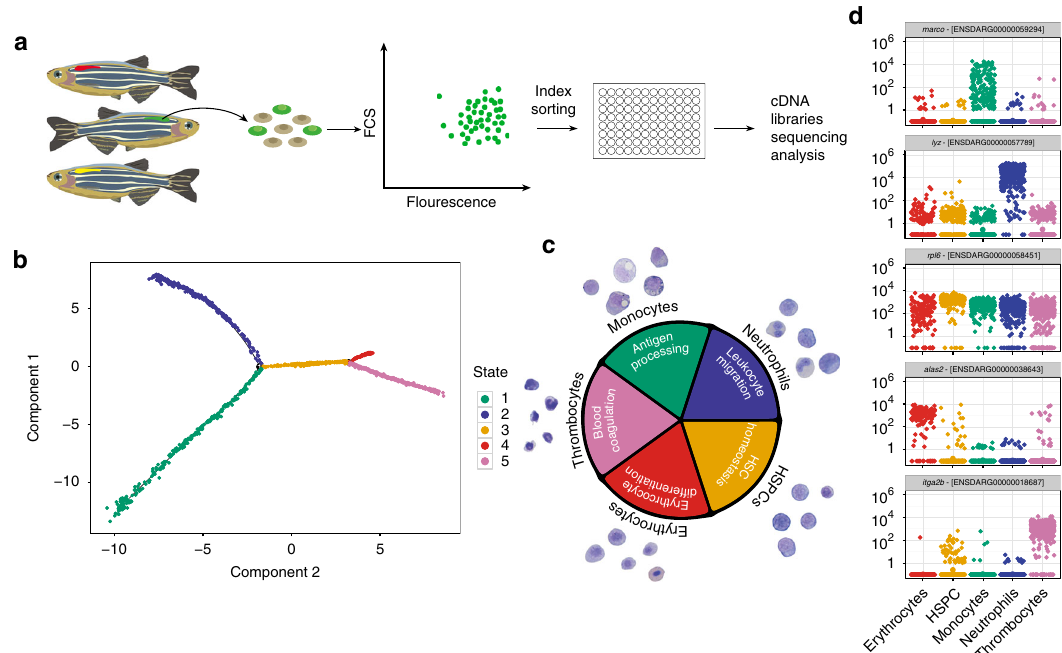
Fig. 1 Pseudotime ordering reveals a gradual transition of cells from immature to more differentiated within the myeloid branch. a Experimental strategy for sorting single cells from transgenic zebra fi sh lines. Cells were collected from a single kidney of each line and sorted for expression of the fl uorescent transgene. Index sorting was used to dispense single cells into a 96-well plate and these were subsequently processed for RNA-seq analyses. b Five cell states were predicted using the Monocle2 algorithm for temporal analyses of single-cell transcriptomes. c Analysis of genes that are differentially expressed across the fi ve states (given the same colour code used in b ) reveals GO terms (inner circle) that are highly pertinent to speci fi c cell types. The outer circle shows examples of May – Grünwald Giemsa-stained cells from kidneys of transgenic lines that largely label each particular cell type. d Jitter plots showing the expression ( y axis) of differentially expressed marker genes in each cell type ( x axis). Each dot in the jitter plot shows the expression of the gene log 10 (counts +1) in each